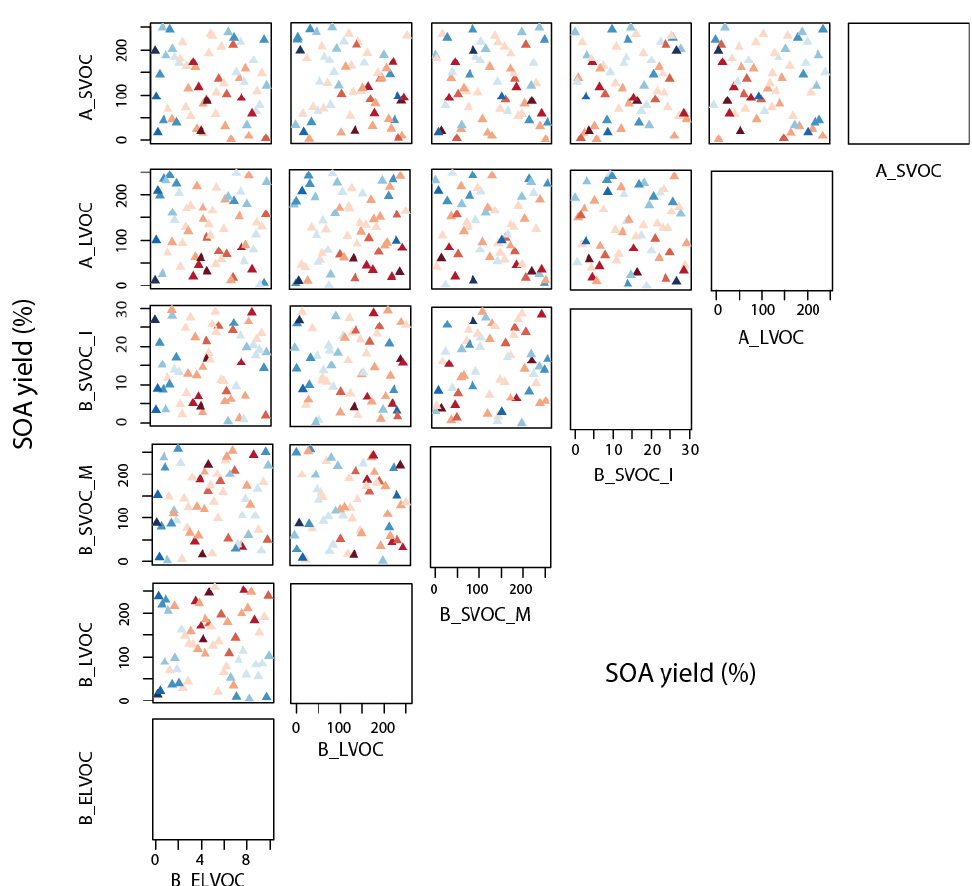
Figure 10. Taylor skill score for model simulations against N3 observations across the 6-D parameter space. The x and y axes for a subplot show the total range of reaction yields (%) over which each of the two parameters (as indicated by the plot labels at the top and right for each subplot respectively) is perturbed in the ensemble. Each triangle in a subplot represents a simulation, and the color of the triangle indicates its Taylor skill score for N3. Darker shades of blue indicate low/poor Taylor skill score and darker shades of red represent high/good Taylor skill score. Figure A3 shows the same plot with ensemble members numbered. Note the axis for B_ELVOC shows the scaling factor for B_ELVOC yields. Axes for the rest show the corresponding ox-VOC yields.